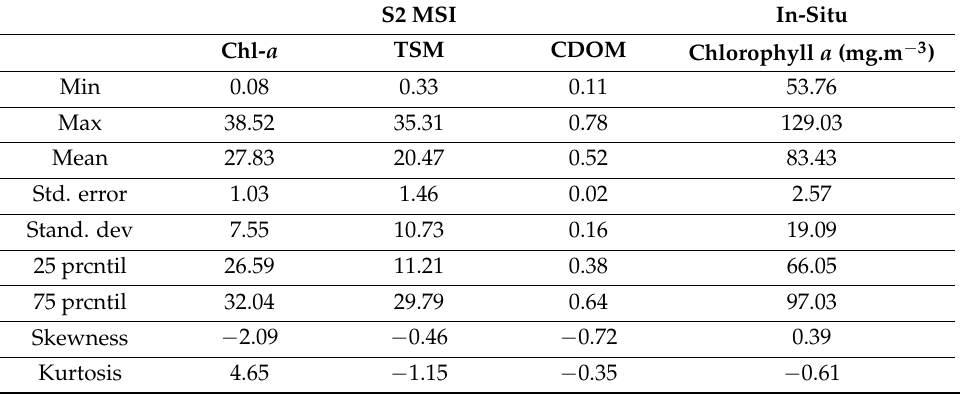
The in-situ data indicated that the Burullus Lake water is hypertrophic with a wide Table 9. Summary statistics of the MSI Chl- a , TSM, and CDOM contents and the in-situ measured variation of Chl- a blooms (av. 83.4 mg.m − 3 and range levels of 53.76–129 mg.m − 3 ). The MSI- chlorophyll- a in Burullus estimated that Chl- a showed a range level of 0.08–38.52 mg.m − 3 with average of 27.83